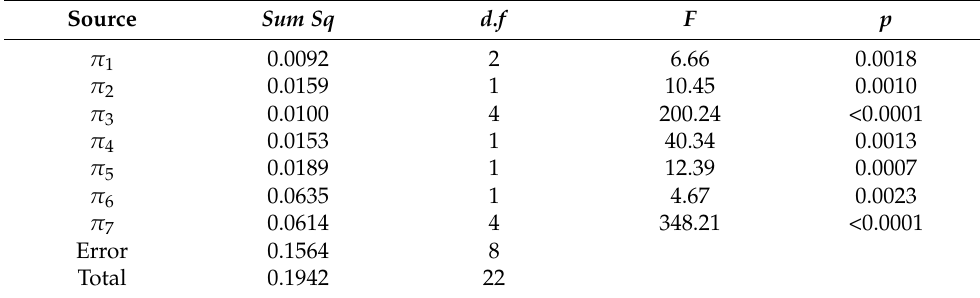
Table 4. Analysis of variance (ANOVA) table to assess design parameters (dimensionless groups) in a WAG injection process [ d.f stands for the degree of